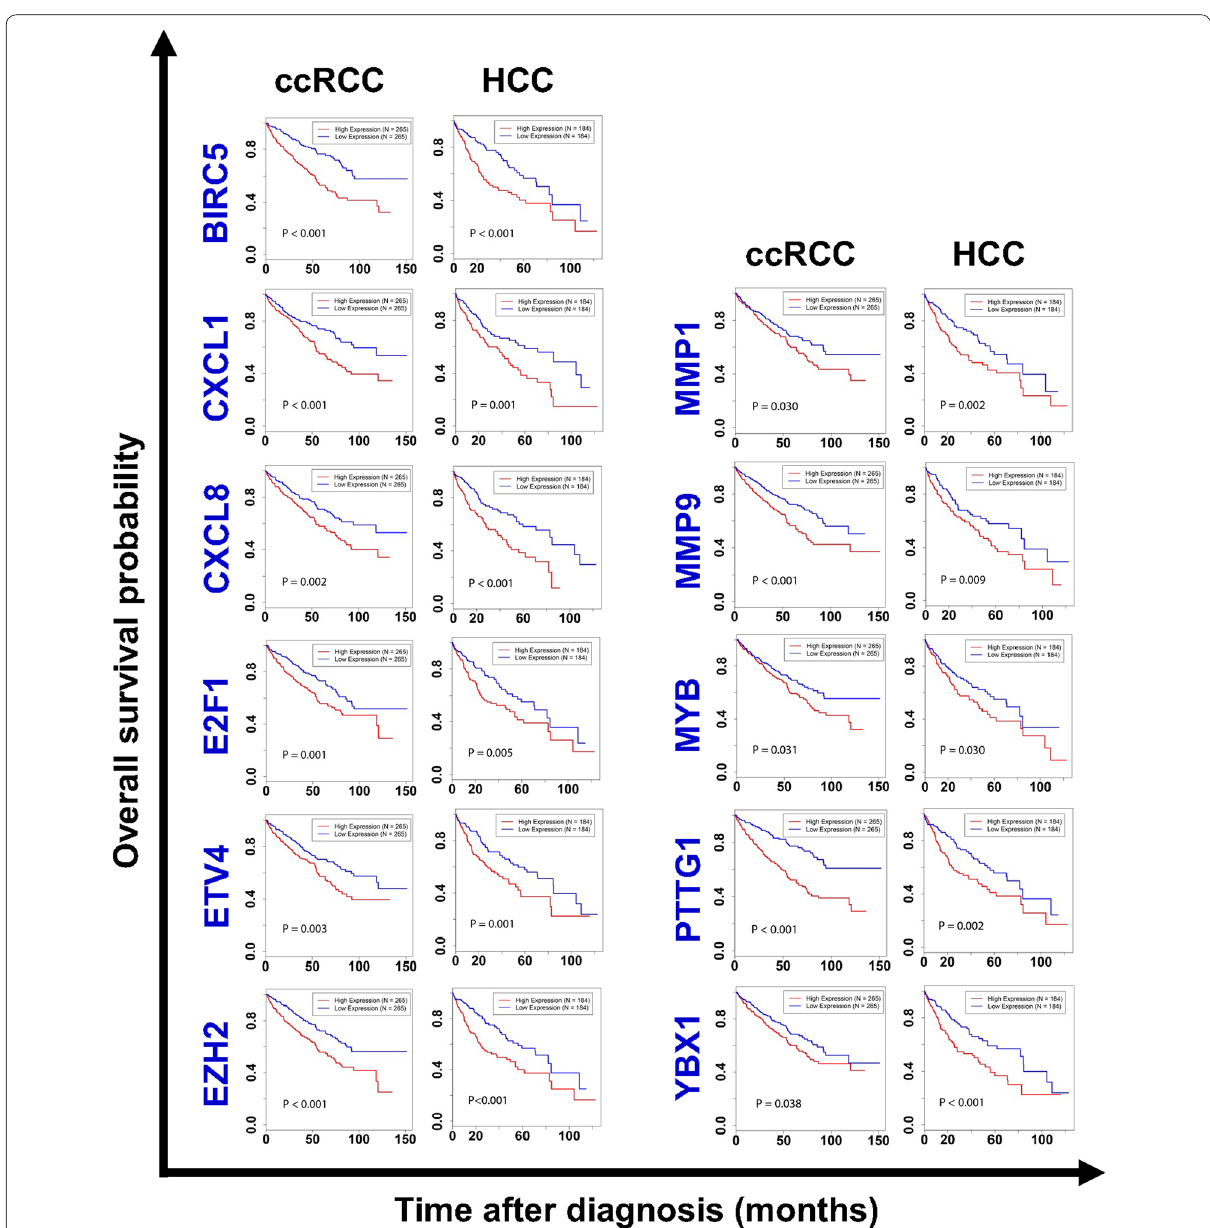
Fig. 2 The survival curves of two cohorts of cancer patients comparing the mRNA expression levels of 11 genes. The data were retrieved from The Cancer Genome Atlas (TCGA) database. The survival curves were plotted using the Kaplan–Meier method and compared using the log‑rank test. Consistently, among all 11 genes presented in this figure, elevated gene expression levels significantly associate with shorter overall patient survival ( P < 0.05) in both tumor types. ccRCC clear cell renal cell carcinoma, HCC hepatocellular